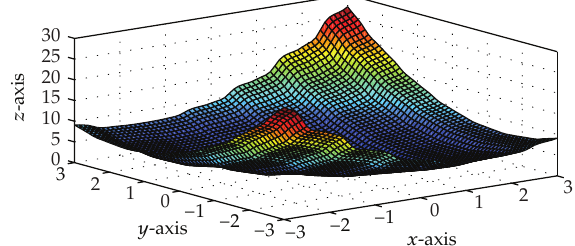
(cid:28) δ j (cid:8) 8.